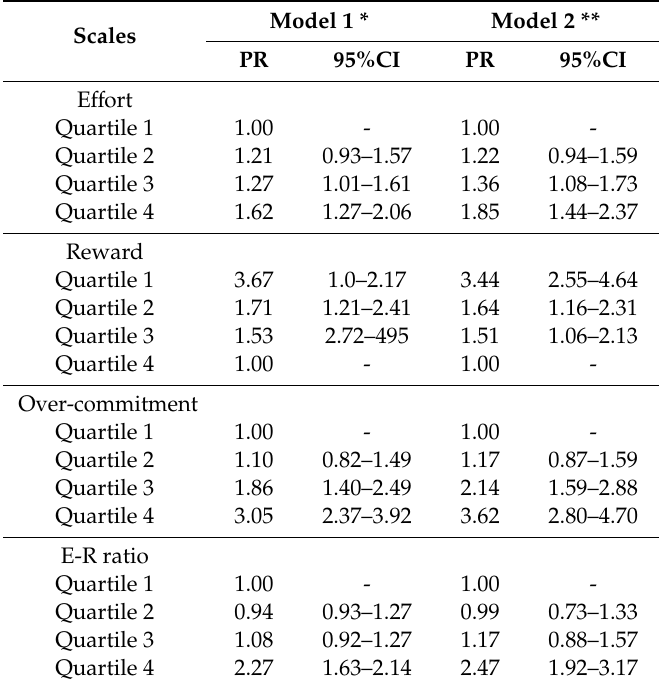
Table 3. Association between ‘e ff ort’-‘reward’ imbalance and depressive episodes including prevalence ratio (PR) and respective 95% confidence intervals. ELSA-Brasil, 2012–2014.